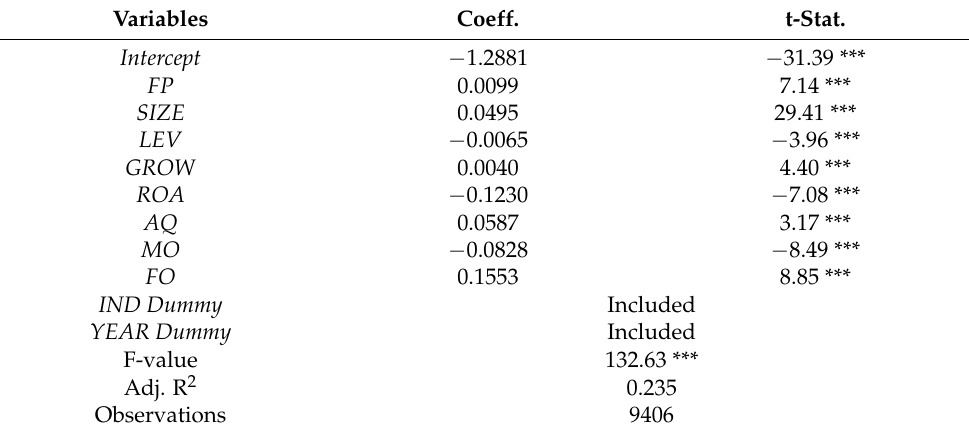
Table 5. The regression result of